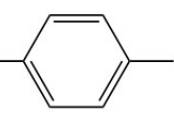
Figure 5. DMeAzetA ( left ) and DMeAzirA ( right ) molecular